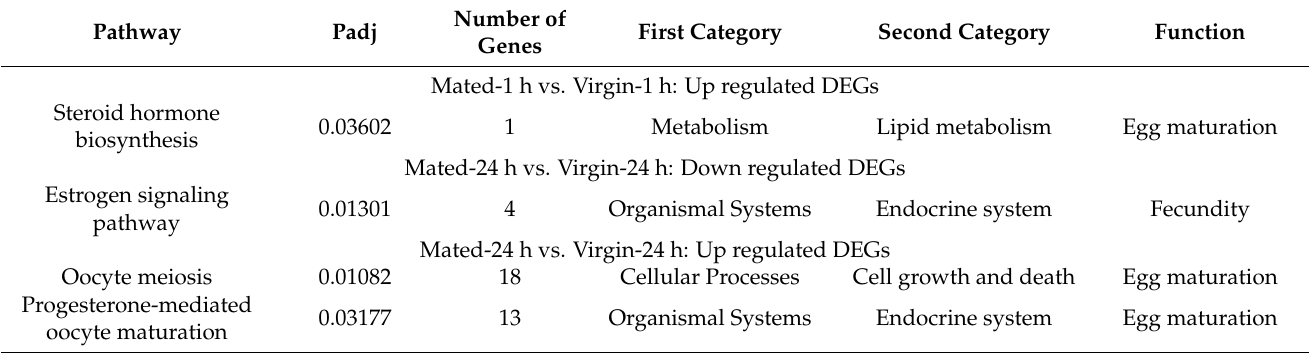
Table 2. Reproductive related KEGG pathways of DEGs in C. chuxiongica